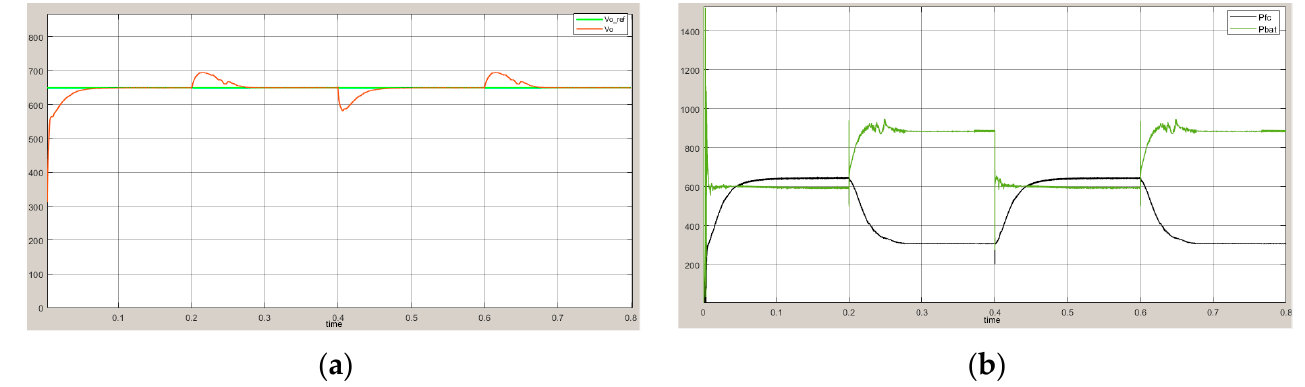
Figure 6. The effect of controller under working state 3: ( a ) output voltage under variable voltage scaling conditions; ( b ) result of proportional change in power input. When the topology is operating in state 5, Figure 7 shows a schematic diagram of the battery port maintaining a constant voltage when the load feedback voltage varies depending on the braking effect.